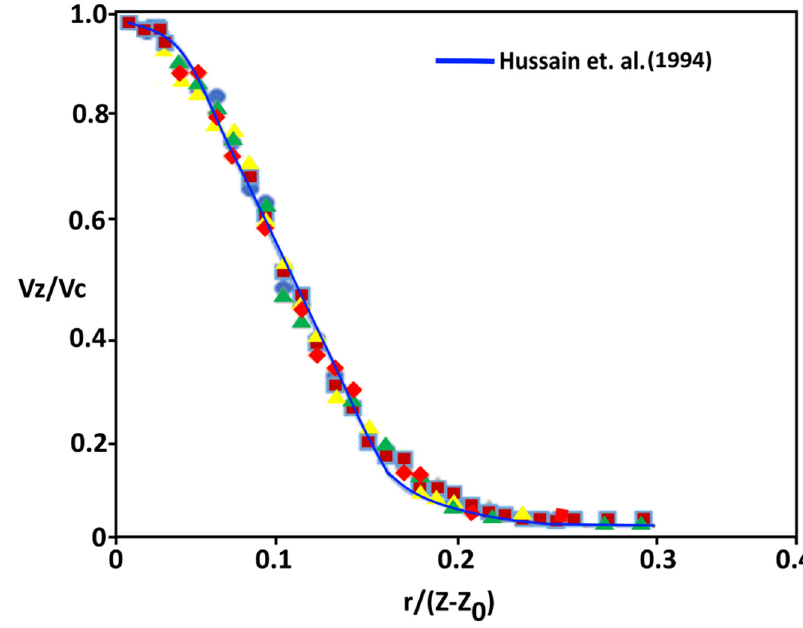
Figure 9. Self-preserved mean axial velocity profile across the width of the plume.